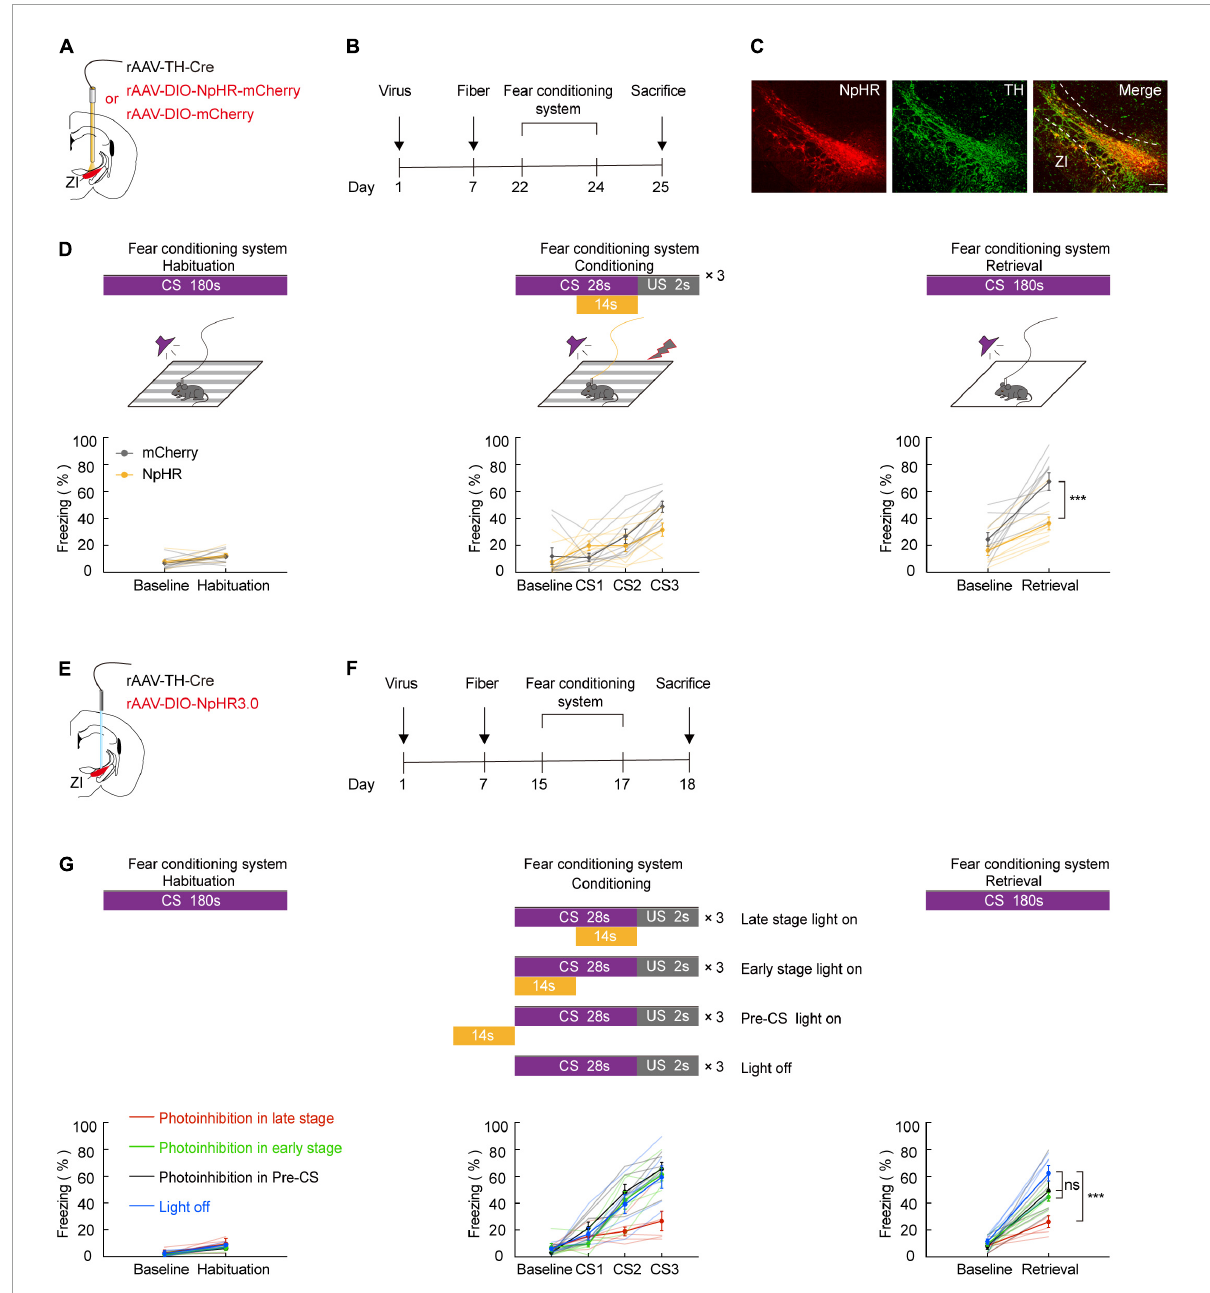
FIGURE2 Photogenetic inhibition of ZI TH + neurons in the late stage of CS disrupted conditioned fear learning in mice. (A) Schematic representation of the virus injection and optic fiber implantation. (B) Experimental protocol timeline. (C) Representative image of NpHR3.0-mCherry expression in the ZI TH-positive cells dominantly. NpHR3.0 is shown in red, TH + is shown in green, and co-expressed cells are shown in yellow. Scale bar, 500 µ m. (D) Behavioral paradigm of fear-conditioning system and its corresponding freezing behavior (habituation phase, two-way RM ANOVA, group: p = 0.5041, time: p = 0.0033, interaction: p = 0.8917; post hoc Sidak’s test, Baseline: mCherry vs. NpHR3.0: p = 0.8144; Habituation: mCherry vs. NpHR3.0: p = 0.9130. Conditioning phase, two-way RM ANOVA, group: p = 0.2849, time: p < 0.0001, interaction: p = 0.0146; post hoc Sidak’s test, baseline: mCherry vs. NpHR3.0: p = 0.9645; CS1: mCherry vs. NpHR3.0: p = 0.3209. CS2: mCherry vs. NpHR3.0: p = 0.8012; CS3: mCherry vs. NpHR3.0: p = 0.0693. Retrieval phase, two-way RM ANOVA, group: p = 0.0012, time: p < 0.0001, interaction: p = 0.0467; post hoc Sidak’s test, baseline: mCherry vs. NpHR3.0: p = 0.4568; retrieval: mCherry vs. NpHR3.0: p = 0.0003; mean ± SEM n = 9). (E) Schematic representation of the virus injection and optic fiber implantation. (F) Experimental protocol timeline. (G) Behavioral paradigm of fear-conditioning system and its corresponding freezing behavior (retrieval phase, two-way RM ANOVA, group: p = 0.0008, time: p < 0.0001, interaction: p = 0.0103; post hoc Sidak’s test, retrieval: late stage light on vs. early stage light on: p = 0.0020; late stage light on vs. pre-CS light on: p = 0.0240; late stage light on vs. light off: p < 0.0001; early stage light on vs. pre-CS light on: p = 0.9487; early stage light on vs. light off: p = 0.2049; pre-CS light on vs. light off: p = 0.0260. Mean ± SEM n = 6). ns not significant, *** P ≤